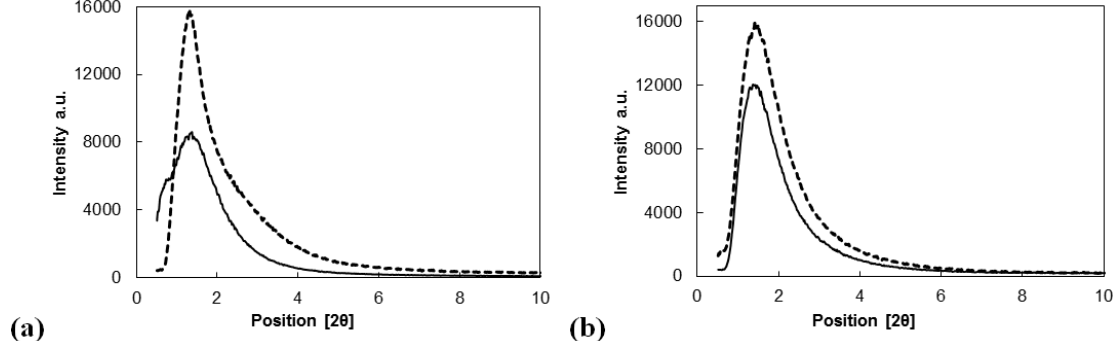
Figure 2. Diffractograms ( a ) of Siral 40 (line) and MTO/Siral 40 (dashed line) (15 mg MTO/100 mg Siral 40) and ( b ) of mesoporous alumina MA 5 (line) and MTO/ZnCl /MA 5 (dashed line) (5 mg MTO/100 mg ZnCl 2